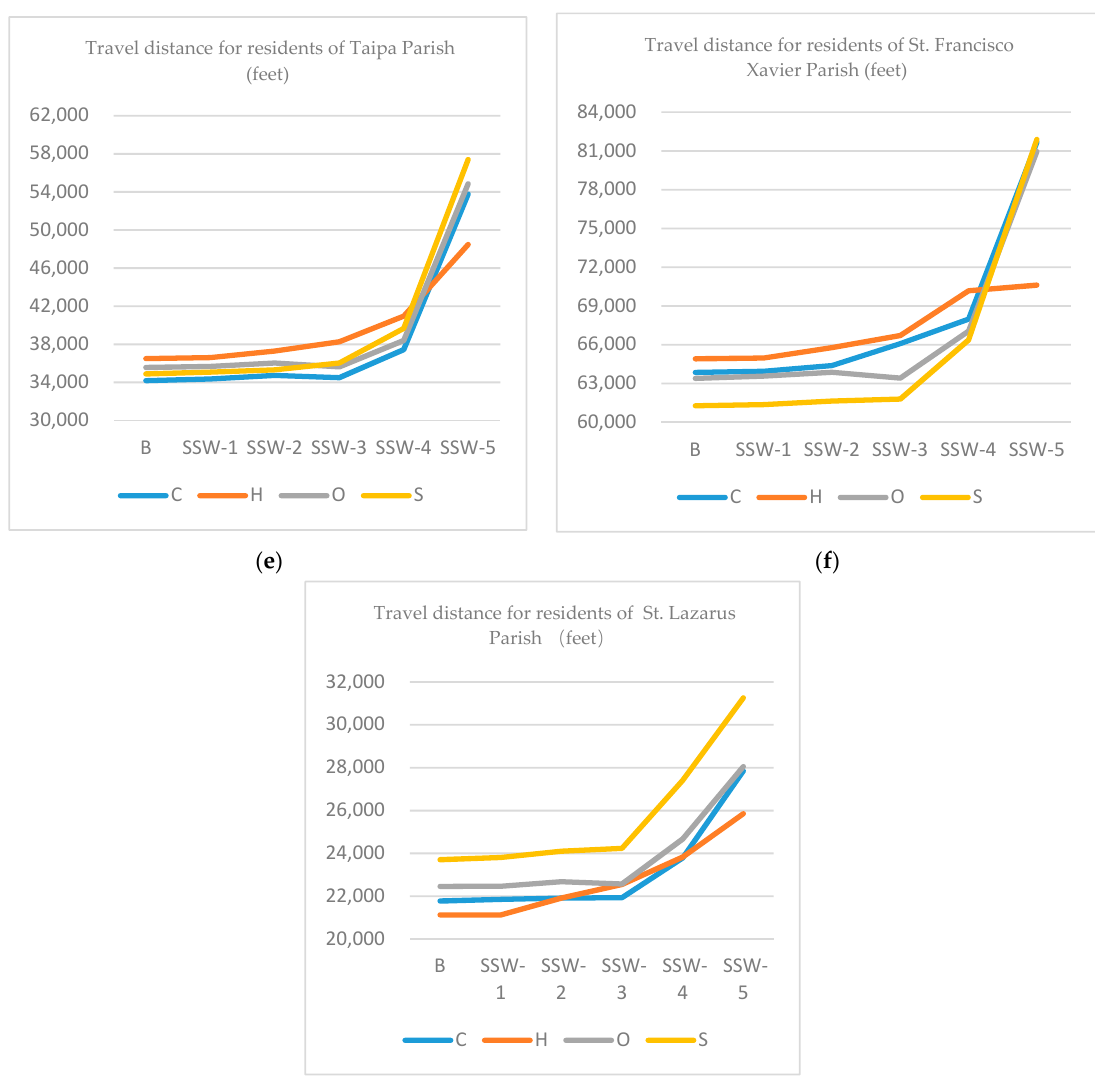
Figure 7. Travel distances from residential areas to commercial, office, educational, and hospital destinations by parish. ( a ) Cathedral Parish; ( b ) St. Lawrence Parish; ( c ) Our Lady Fatima Parish; ( d ) St. Anthony Parish; ( e ) Taipa Parish; ( f ) St. Francisco Xavier Parish; and ( g ) St. Lazarus Parish.